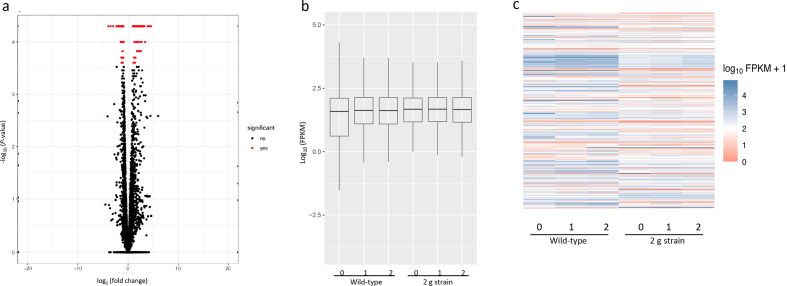
Transcriptomic analysis of alkane overproduction in
N. punctiforme
. (a) Volcano plot showing all significantly regulated genes in the 2 g alkane overproduction strain. (b) Boxplot representation of normalized reads (fragments per kilobase of transcript per million mapped reads; FPKM) for each replicate. Box indicates upper and lower quartile, the bar indicates the median, and the whiskers indicate the highest and lowest values excluding outliers, indicated by circles. (c) Heat map representation of gene expression with twofold differences for each replicate. All figures were generated using the CummeRbund package (v2.30.0) for R.